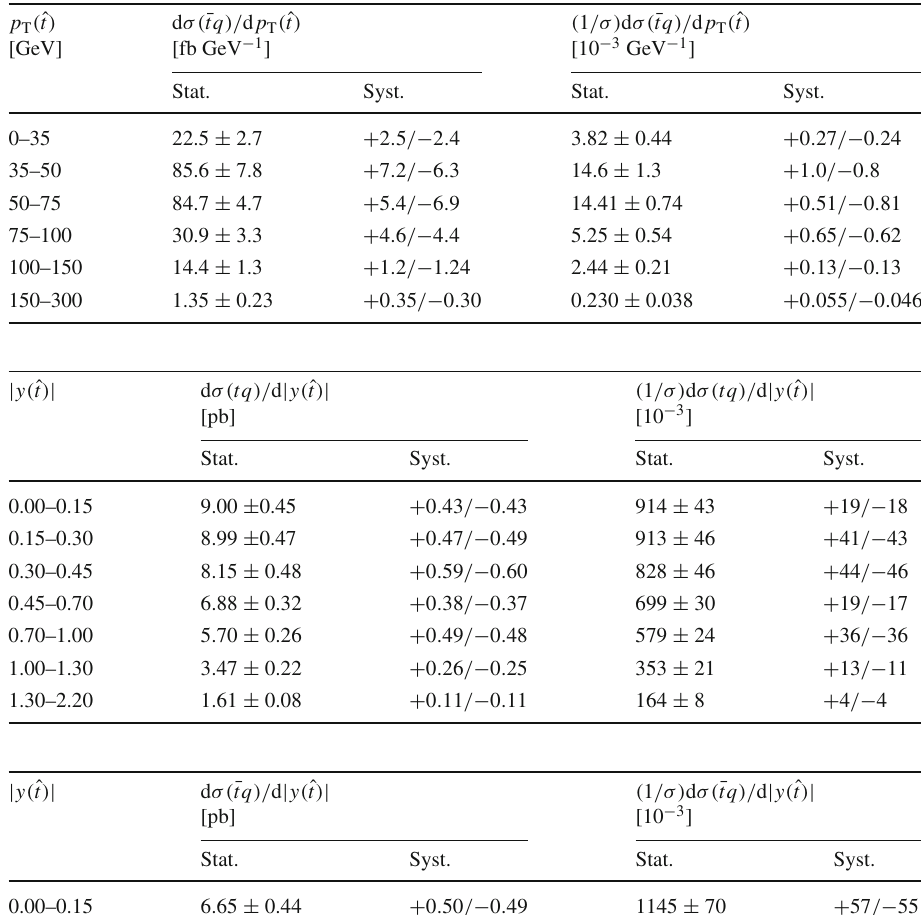
Fig. 19 Absolute unfolded differential cross-sections as a function of p T ( ˆ j ) for a top quarks b top antiquarks. The unfolded distributions are compared to various MC predictions. The vertical error bars on the data points denote the total uncertainty. The inner ( yellow ) band in the bottom part of each figure represents the statistical uncertainty of the measurement, and the outer ( green ) band the total